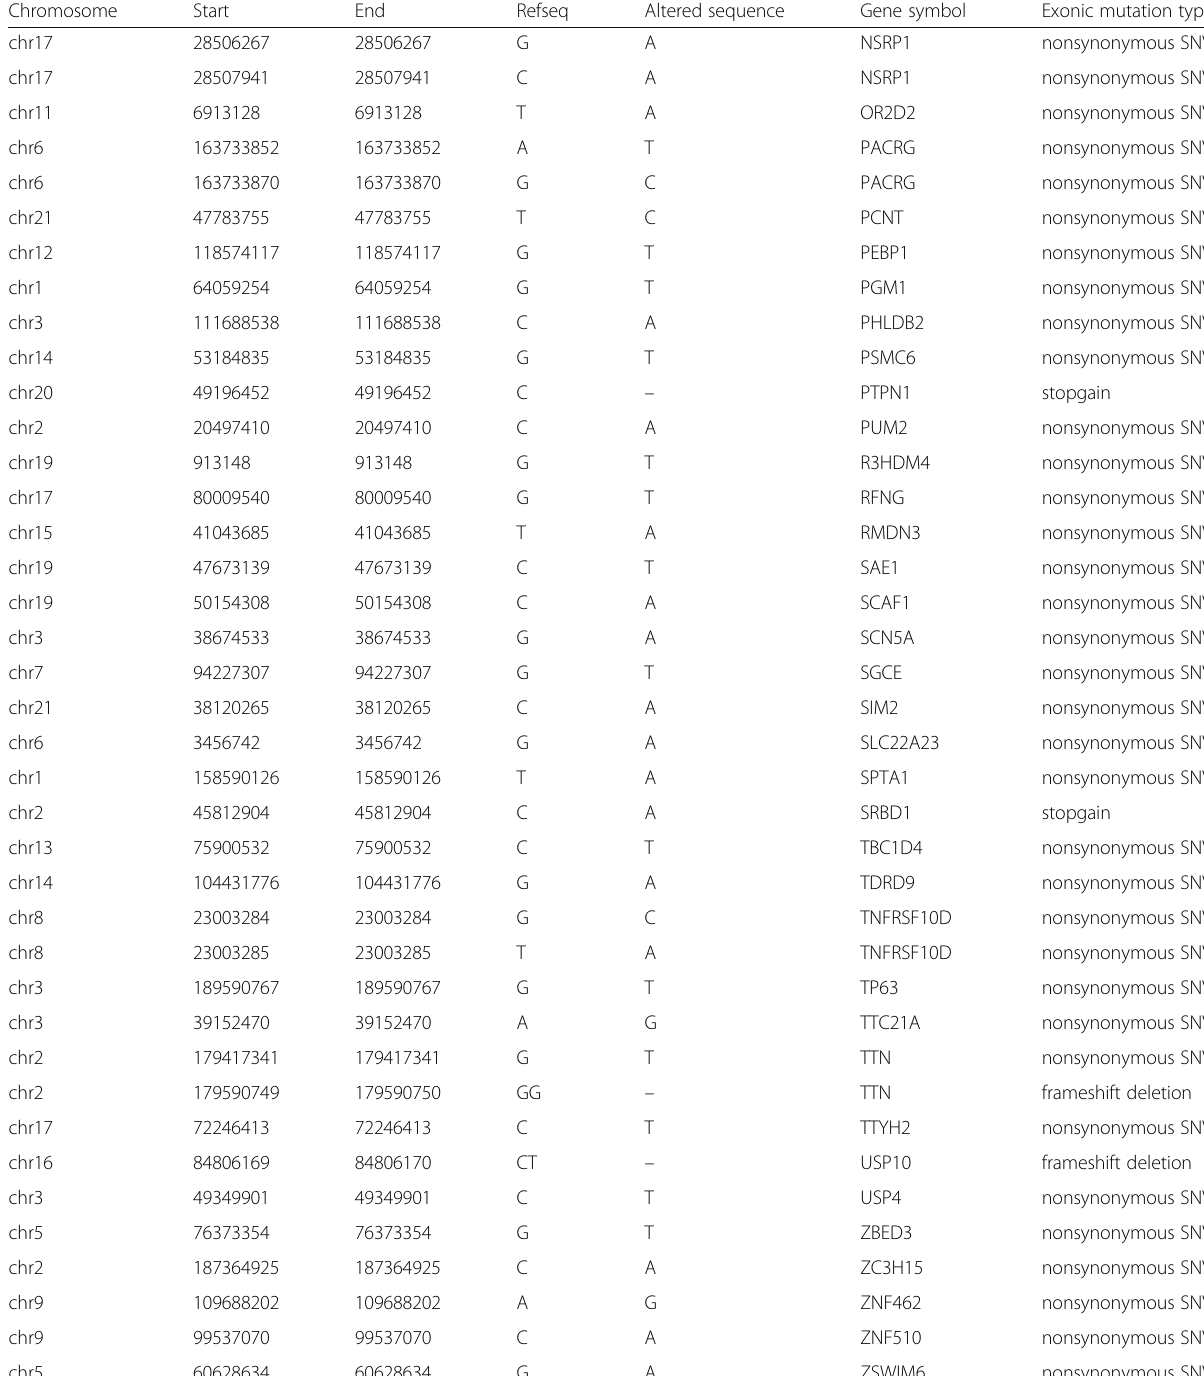
Table 1 Detected nonsynonymous variants in the patient revealed by candidate gene sequencing and confirmed by Sanger sequencing